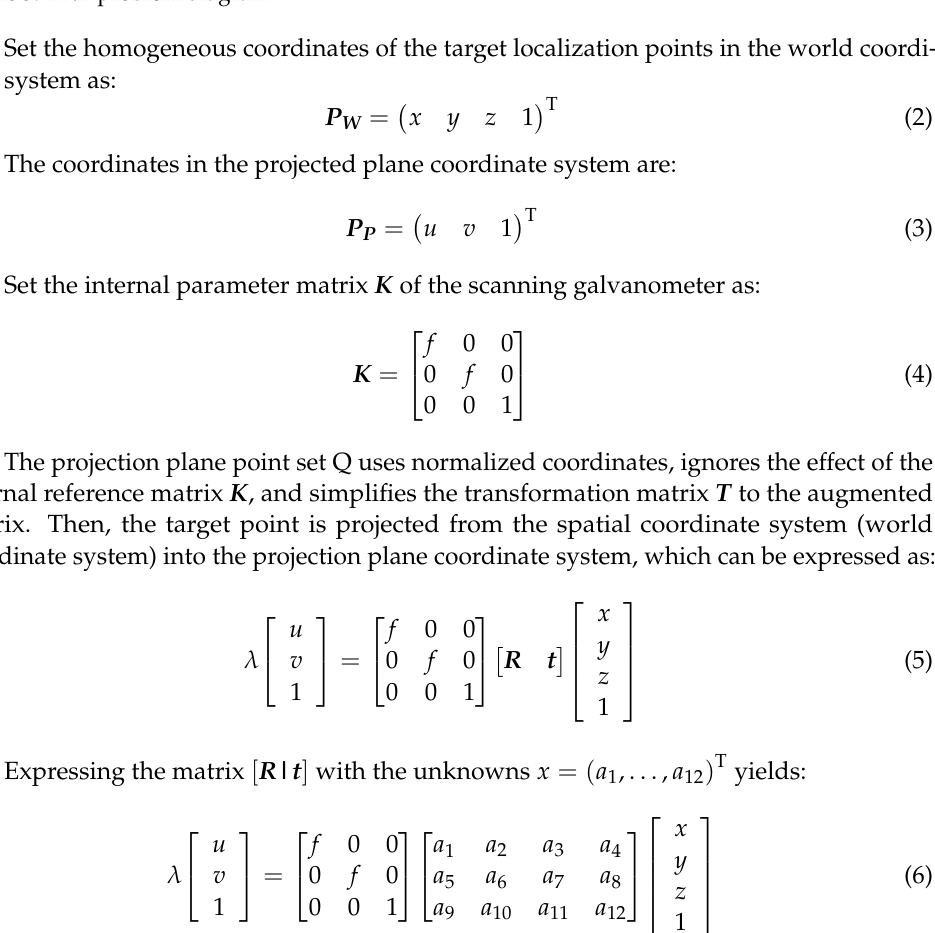
The coordinates in the projected plane coordinate system are: